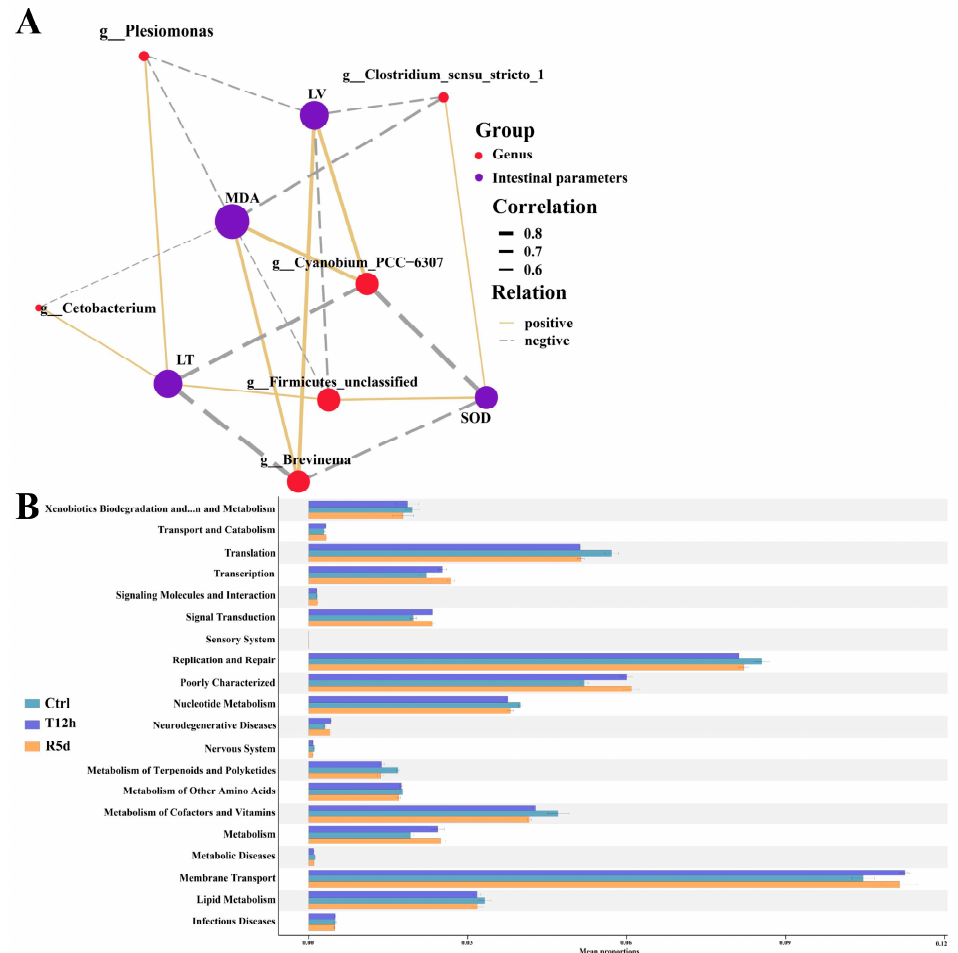
Figure 7. ( A ) Correlation network showing connections between gut microbial genera and intestinal parameters. Line thickness indicates the magnitude of the correlation. LV: intestinal villus length; LT: muscular thickness. ( B ) Functional analysis of the gut microbiota predicted at Level 2 for the control, 12 h transport and recovery groups.